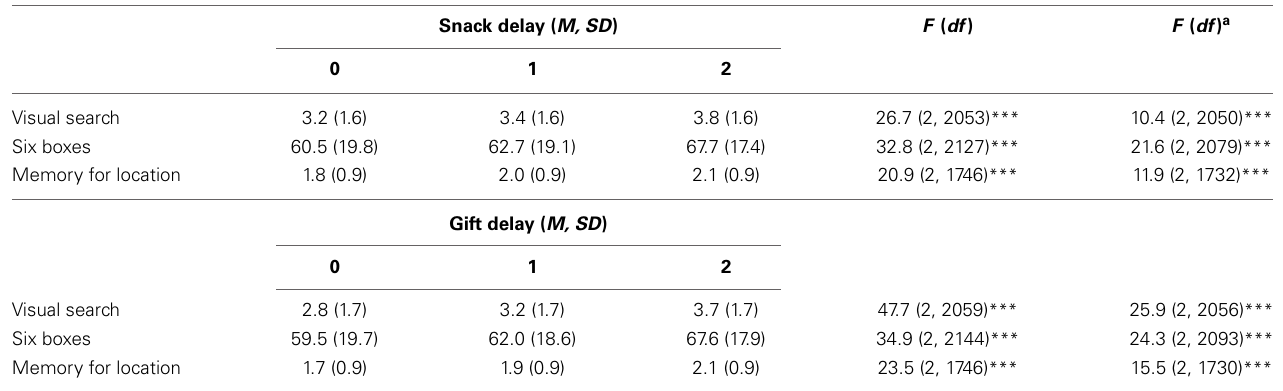
Table 3 | ANOVA with categorical snack and gift delay task scores as independent variables and continuous executive function measures as dependent